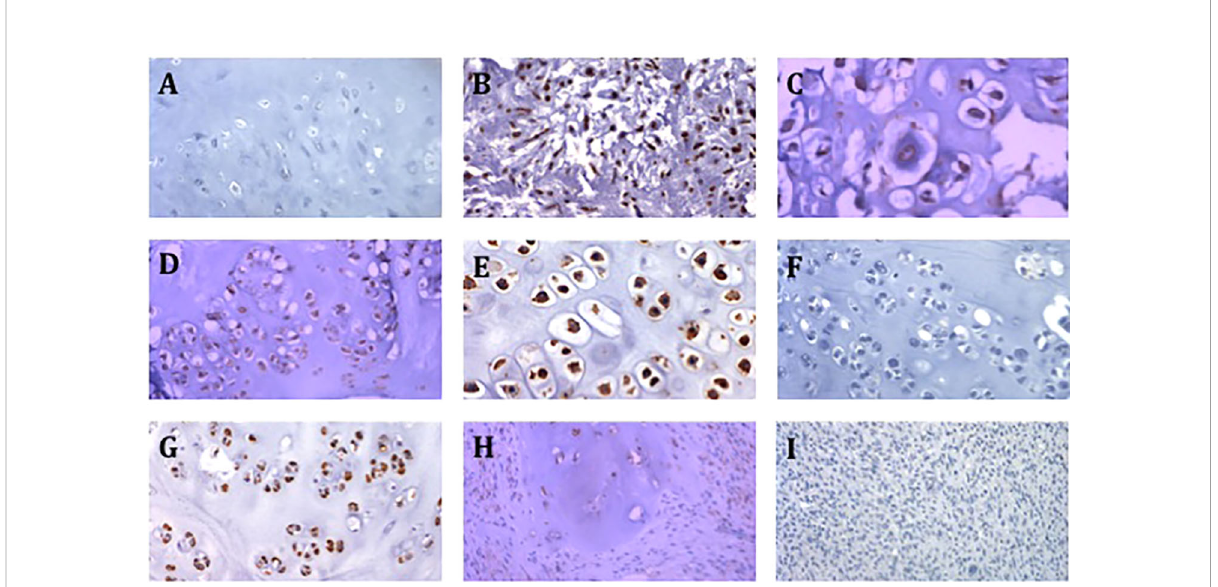
FIGURE 2 Representative images of CSPG4 staining of primary chondrosarcoma tumors. (A) CSPG4 negative stain in enchondroma (200x magni fi cation). (B) CSPG4 positive stain in grade 2 chondrosarcoma (200x magni fi cation). (C) CSPG4 positive stain in grade 2 chondrosarcoma (400x magni fi cation). (D) CSPG4 positive stain in grade 2 chondrosarcoma (200x magni fi cation). (E) CSPG4 positive stain in grade 2 chondrosarcoma (400x magni fi cation). (F) CSPG4 negative stain in grade 2 chondrosarcoma (200x magni fi cation). (G) CSPG4 positive stain in grade 2 chondrosarcoma (200x magni fi cation). (H) CSPG4 positive stain in dedifferentiated chondrosarcoma (200x magni fi cation). (I) CSPG4 negative stain in dedifferentiated chondrosarcoma (200x magni fi